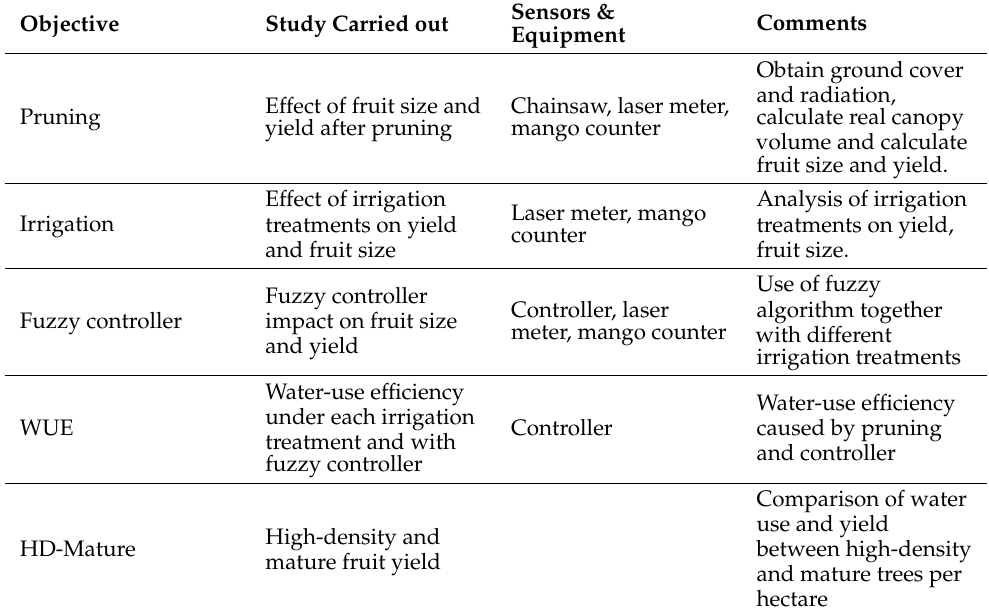
Table 2. Main studies carried out during both seasons, equipment used and some comments during its